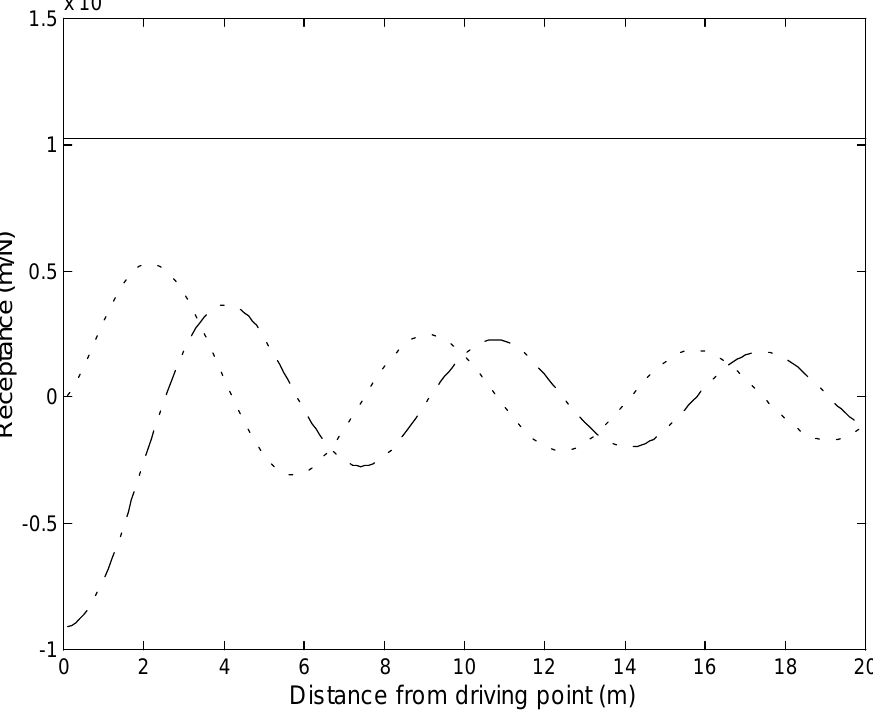
Fig. 9. The comparison of real and imaginary parts of receptance with the variation of distance from driving point under the light fluid loading. Frequency is 50 Hz with plate thickness 0.04 m. —, point receptance (pure imaginary); − − -, real part of transfer receptance; − - − , the imaginary part of transfer